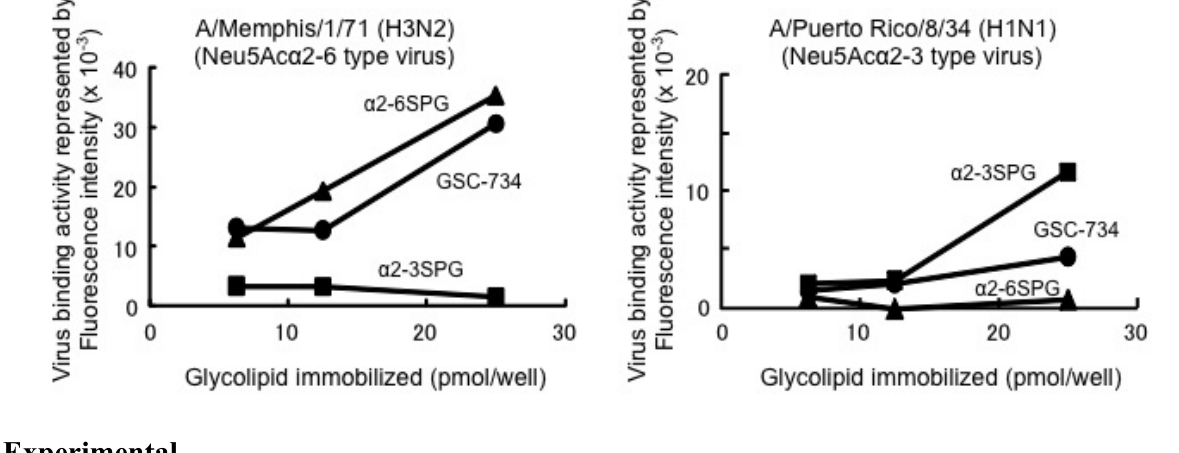
Figure 3. Binding activity of the synthetic ligand ( GSC-734 ) for influenza A